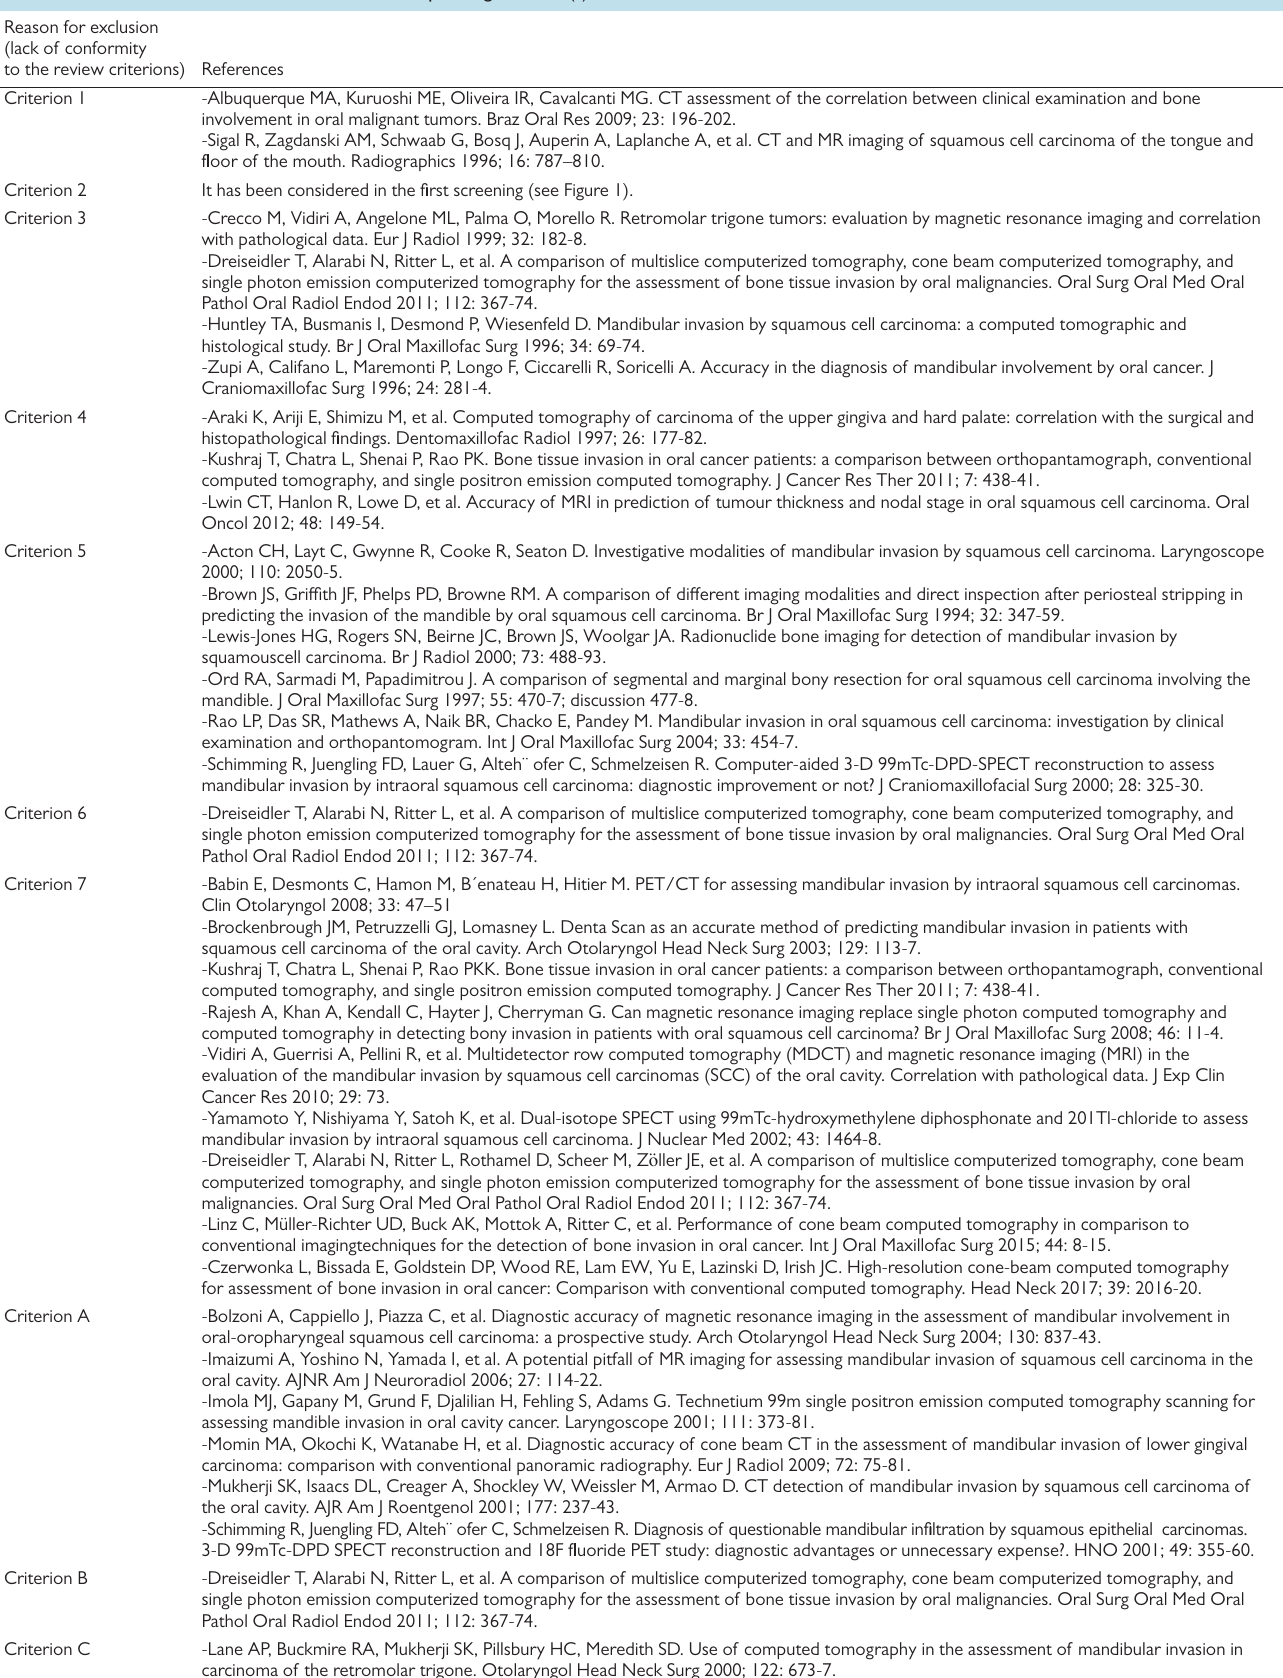
Table 2. Studies excluded in relation to the non-responding criterion(s) Reason for exclusion (lack of